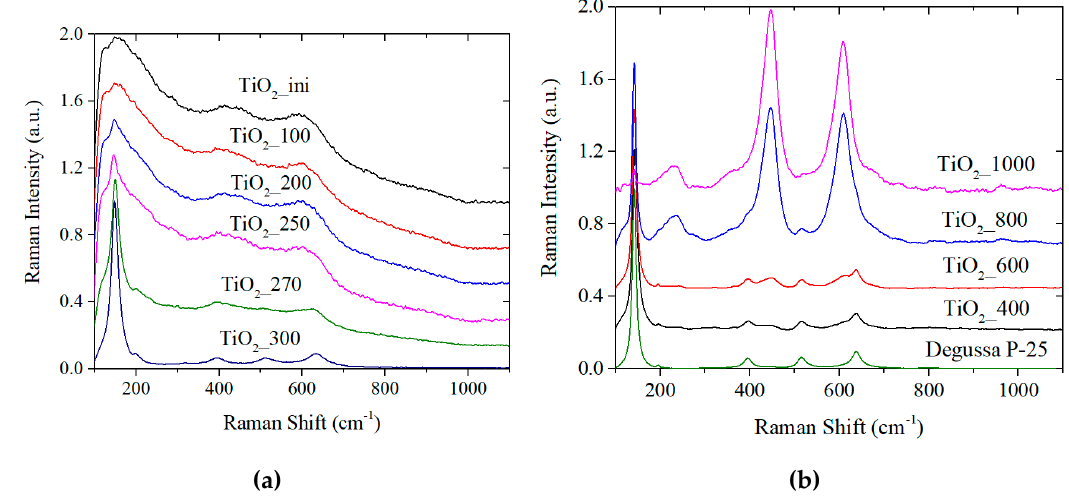
Figure 4. Raman spectra of the samples annealed under different temperatures: ini–300 °C ( a ) and 400–1000 °C ( b ).